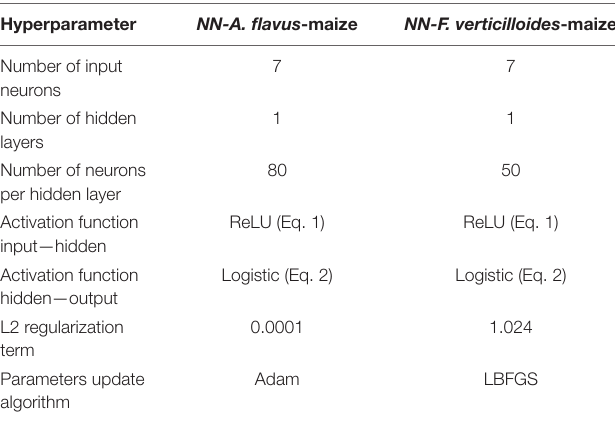
TABLE 4 | Hyperparameter values used to implement the neural networks A. flavus -maize (NN- A. flavus -maize) and F. verticilloides -maize (NN- F. verticilloides -maize)